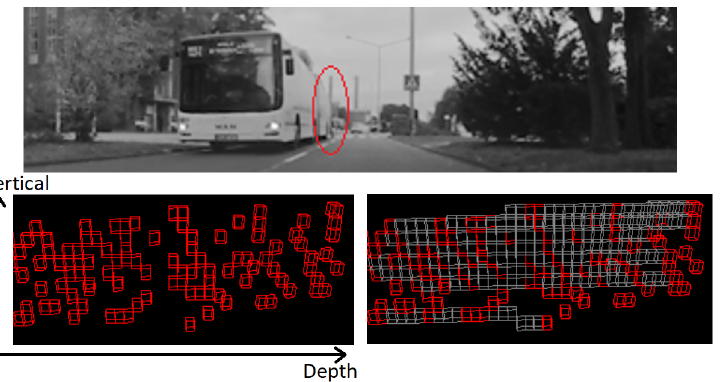
Figure 8. The farthest part (encircled with red, ( top image )) of the lateral side of the bus has consecutive LiDAR measurements that are not connected in the voxel space (( bottom-left image ): side view, red voxels). After densification, the introduction of the intermediate voxels (gray) provides an increased level of connectivity (( bottom-right image ): side